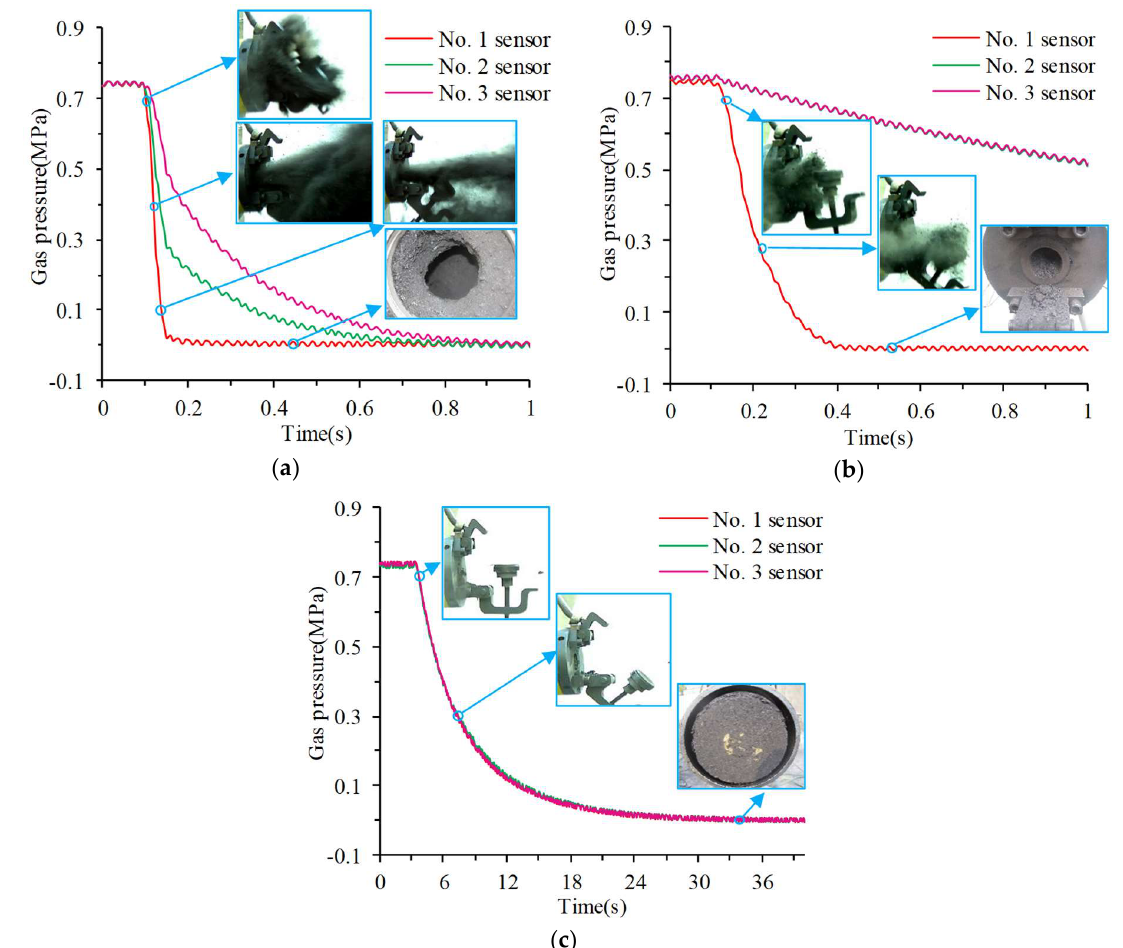
Figure 6. Gas pressure and corresponding experimental phenomena in the outburst process: ( a ) Outburst experiment with CO 2 (gas 7); ( b ) Outburst experiment with 70% N 2 + 30% CO 2 (gas 4); ( c ) Outburst experiment with N 2 (gas 2).